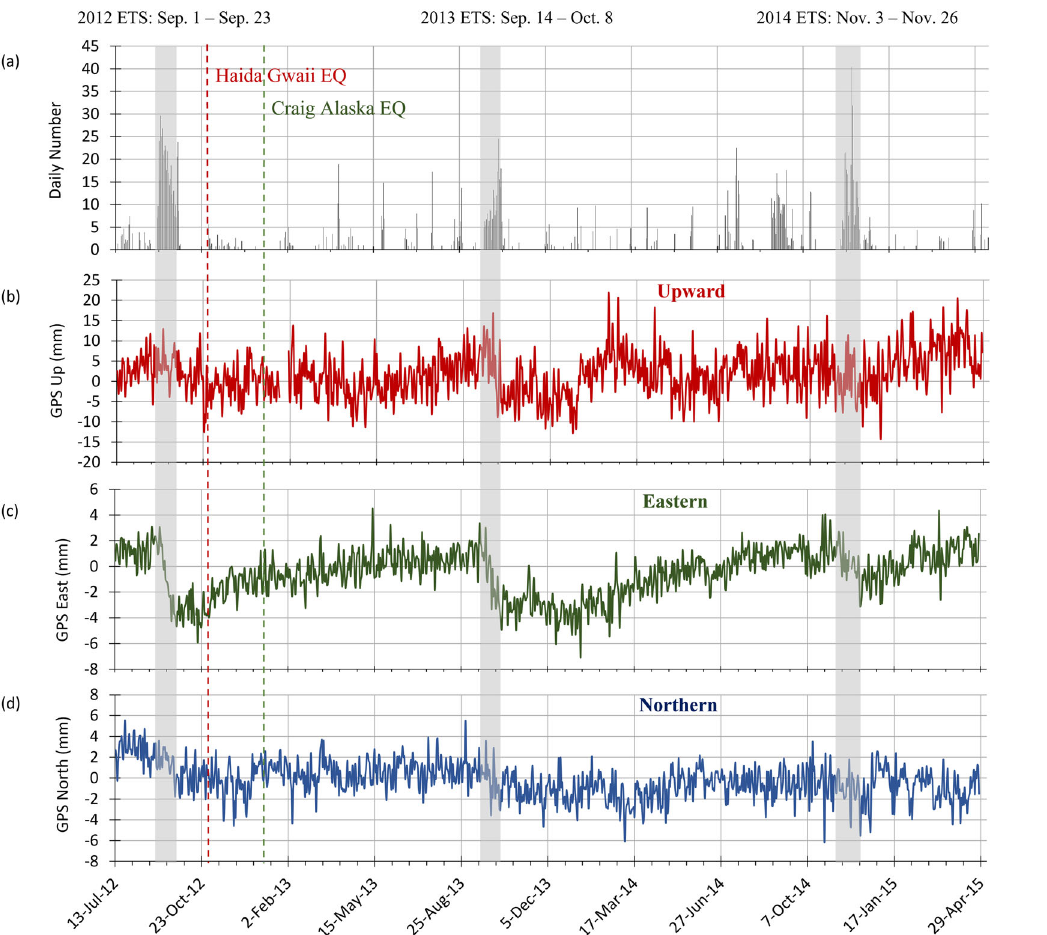
Fig. 3 Tremor and GPS observations at PGC. a Daily number of ETS events; ( b ) Detrended upward movement; ( c ) Detrended eastern movement; ( d ) Detrended northern movement (PGC5 and BCNS stations). The gray time-period columns represent ETS events at CSZ.